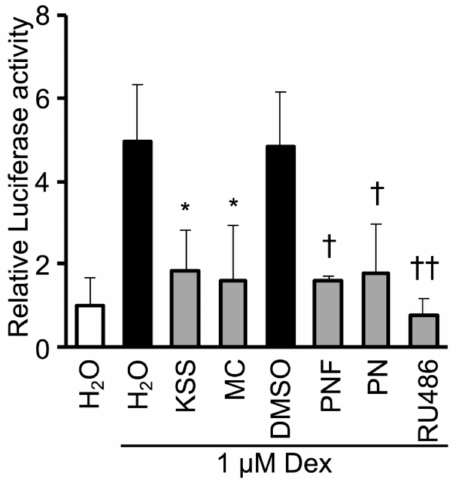
Figure 7. KSS, MC, PNF, and PN inhibit GR promoter activity. In the presence of 1 µ M Dex, 2 mg / mL KSS, 1 mg / mL MC, 1000 µ M PNF, 1000 µ M PN, or 10 µ M RU486 was administered, and a luciferase reporter assay was performed. Dex was used as a positive control for the GR promoter activity, and the relative activity was analyzed. Data are shown as the mean ± standard deviation ( n = 3). * p < 0.05 vs. H 2 O (Dex added). † p < 0.05 and †† p < 0.01 vs. DMSO (Dex